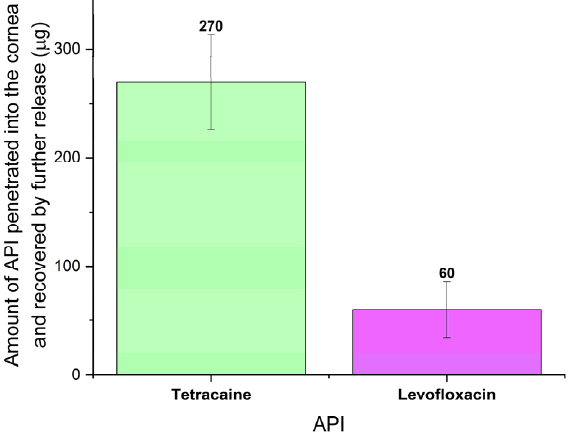
Figure 8. The amount of drug diffused into the cornea during an eight ‐ hour experiment recovered in the subsequent leachate from the cornea. The number of samples was 3 for each measurement. the subsequent leachate from the cornea. The number of samples was 3 for each